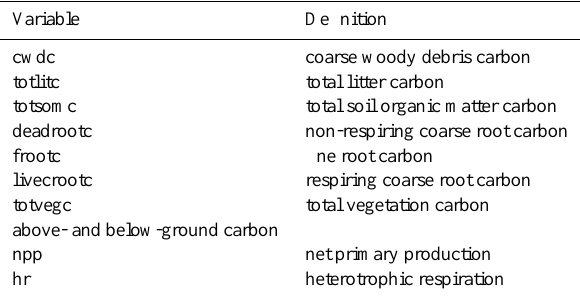
Table 1. Fields input by